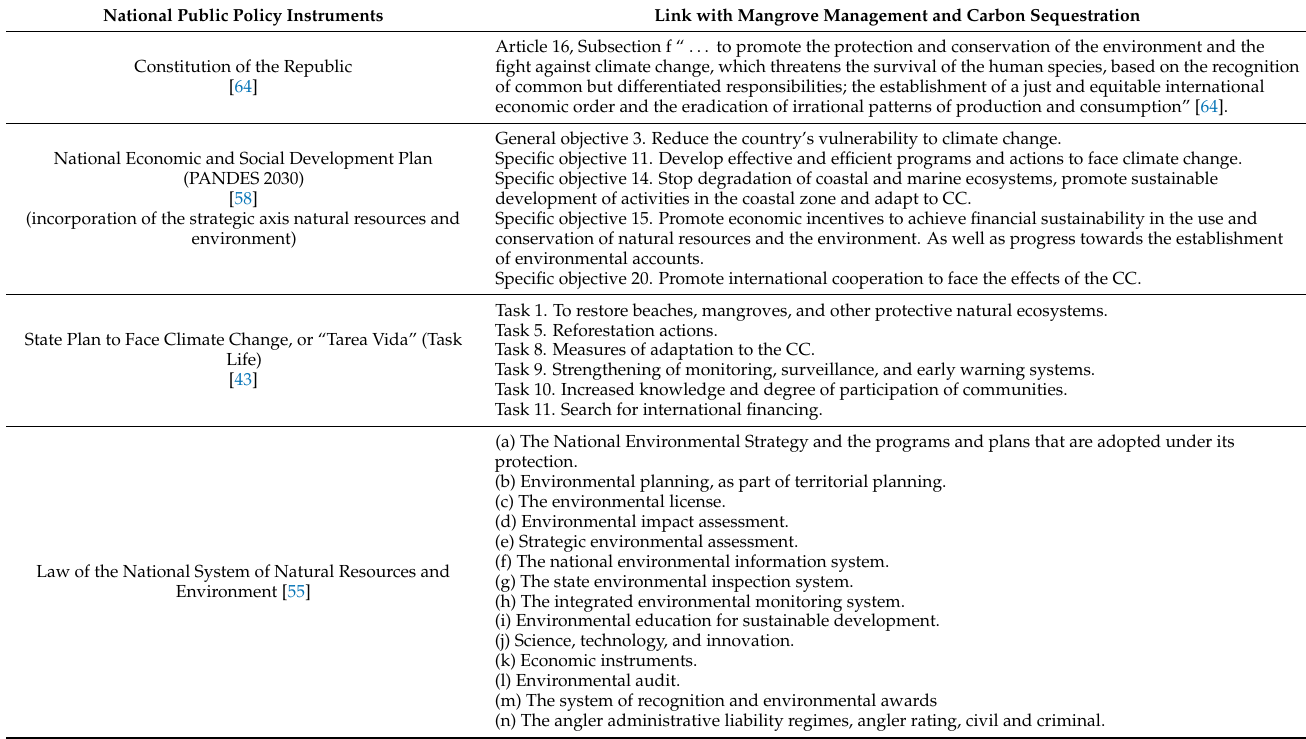
Table 2. Synthesis of the links of the instruments of national public policy in Cuba with mangrove management and carbon